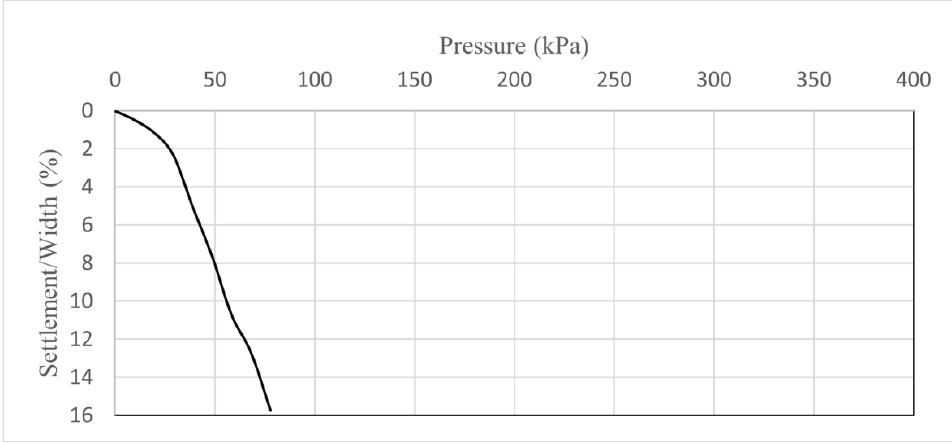
Figure 8. Pressure – settlement relationship for untreated soil.